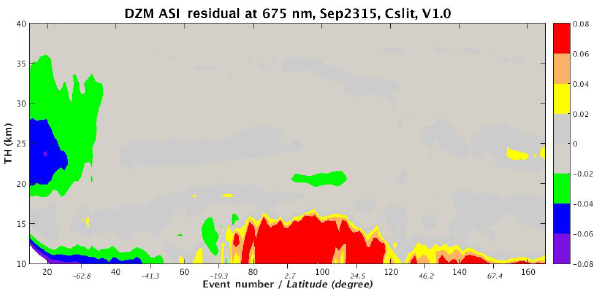
Figure 19. Daily zonal mean aerosol scattering index (ASI, or y ) residuals for center slit observations on 23 September 2015 (derived from the y measurements shown in Fig.